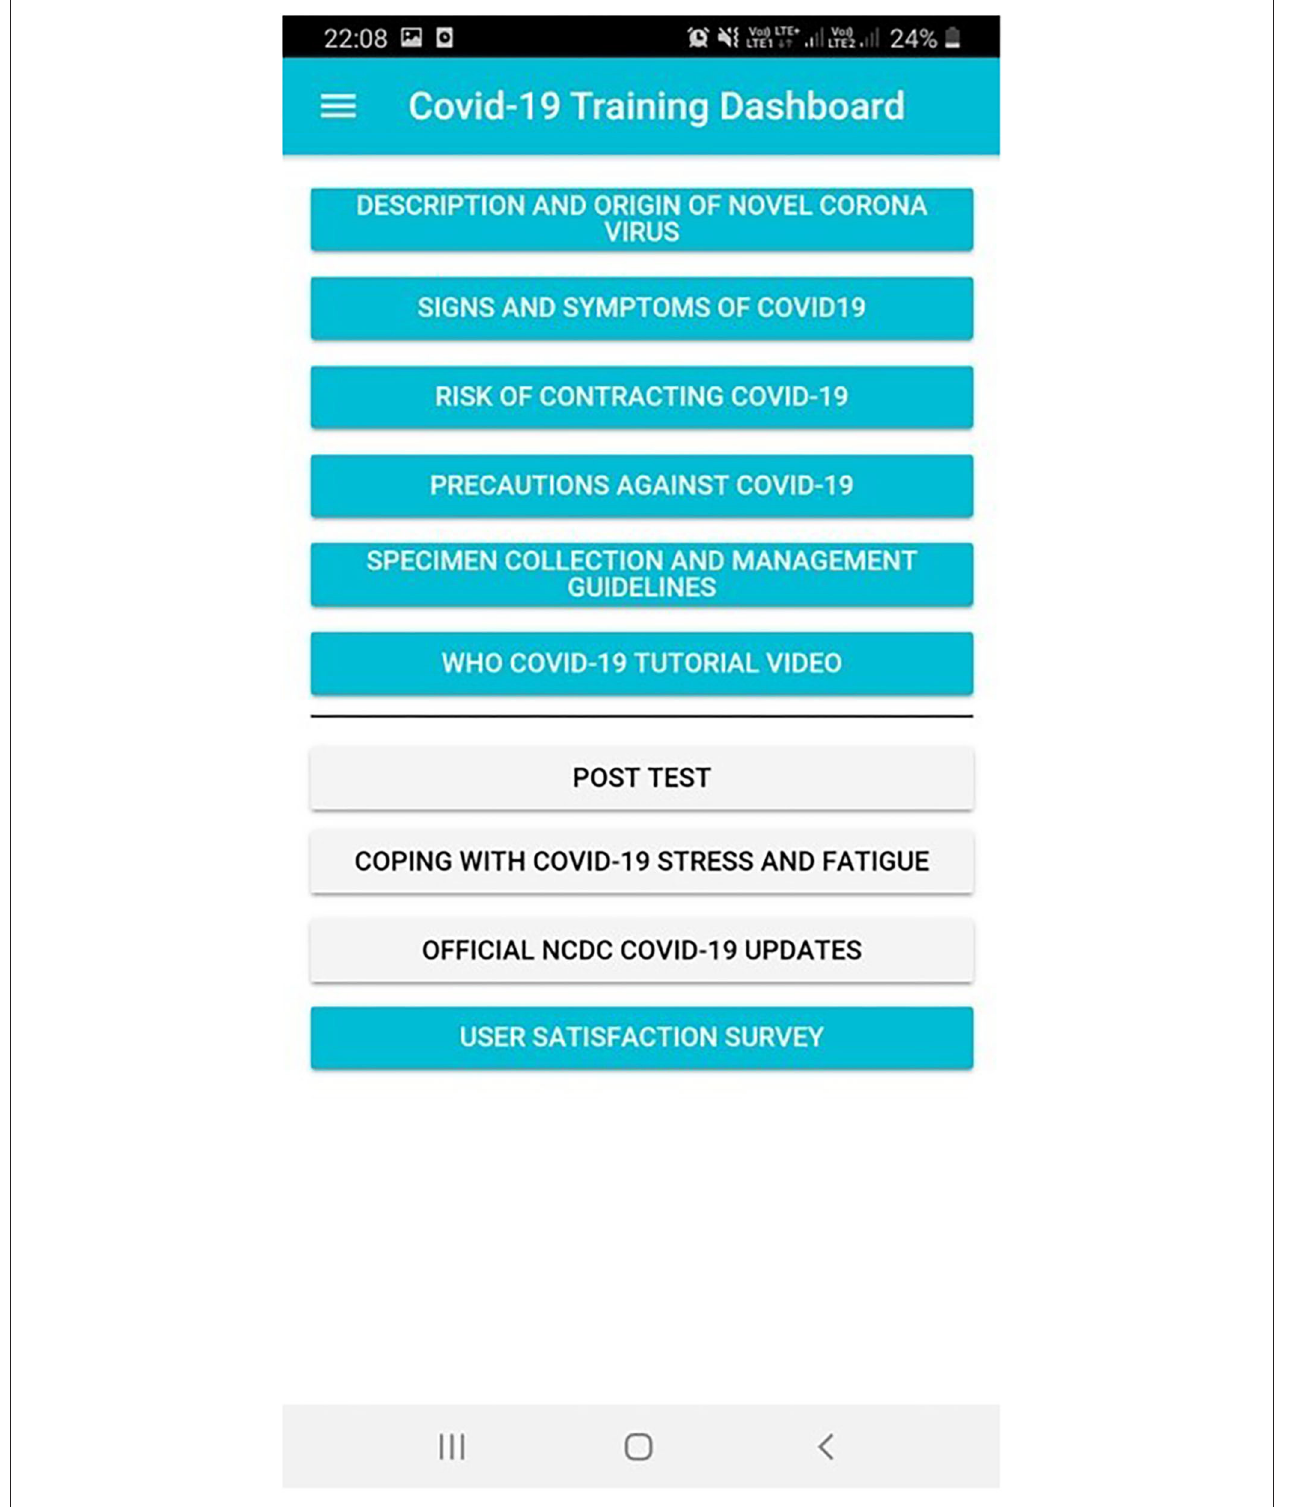
FIGURE 3 | Screenshot showing the InStrat COVID-19 Mobile App ® training dashboard.